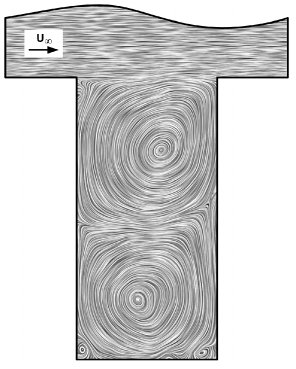
Figure 4. Line integral convolution representation of the velocity vector along the x − z plane. Inset indicates direction of freestream flow.